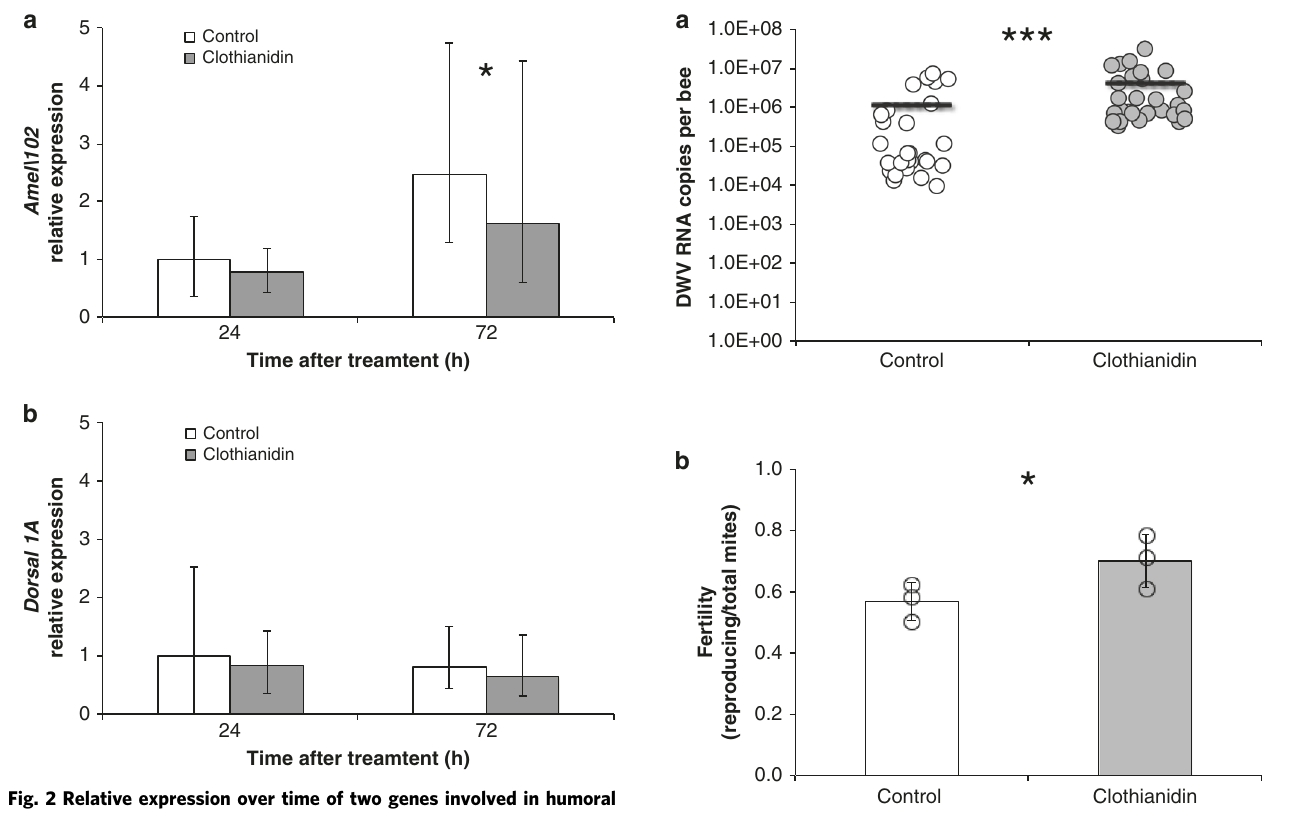
Fig. 3 Clothianidin effect on DWV infection level and Varroa reproduction. Asterisks denote signi fi cantly different mean values (one asterisk: P < 0.05; three asterisks: P < 0.001). a DWV infection level in honey bees eclosed from larvae reared in vitro on a diet with or without Clothianidin (the experiment was run in triplicate, for a total of 28 and 27 individuals for Clothianidin treated and untreated controls, respectively; the horizontal bars represent the sample average; Mann – Whitney U test: n 1 = 28, n 2 = 27, U = 140, one tailed P < 0.001). b Fertility of Varroa mites on honey bee larvae treated with Clothianidin or on untreated controls (the experiment was run in triplicate, for a total of 111 and 120 individuals for Clothianidin treated and untreated controls, respectively; the proportion of reproducing mites in each replicate along with the average fertility and relative standard deviation are reported; Mantel – Haenszel test: df = 2, M – H Chi-2 = 3.970, P =